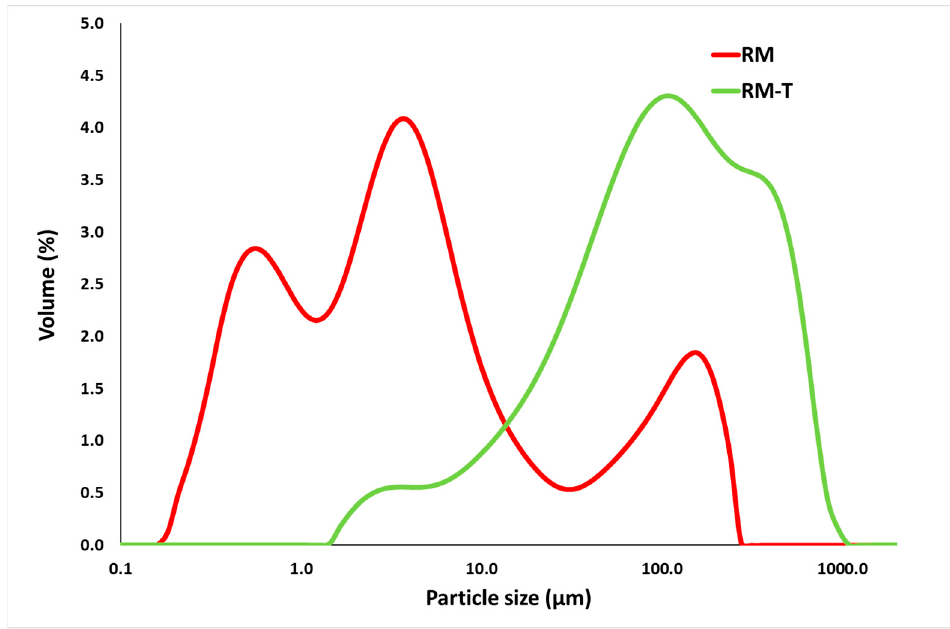
Figure 3. Particle size distribution of red mud before and after leaching extraction.